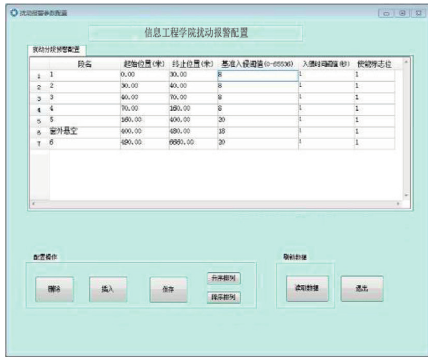
Figure 15: System parameter setting module interface diagram.